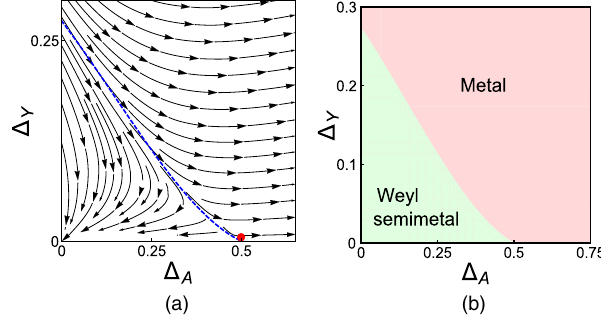
FIG. 11. (a) The renormalization-group flow diagram and (b) corresponding phase diagram in the Δ X ¼ V , A and Y ¼ M , C obtained from Eq. (35). In these planes there is only one QCP at Δ phase boundary between the Weyl semimetal and metal in (b) is determined by the irrelevant direction, shown by blue dotted line in (a).